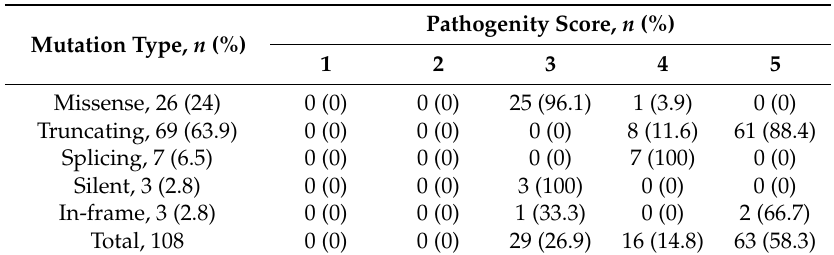
Table 2. Classification of the NF1 mutations according with pathogenicity score.